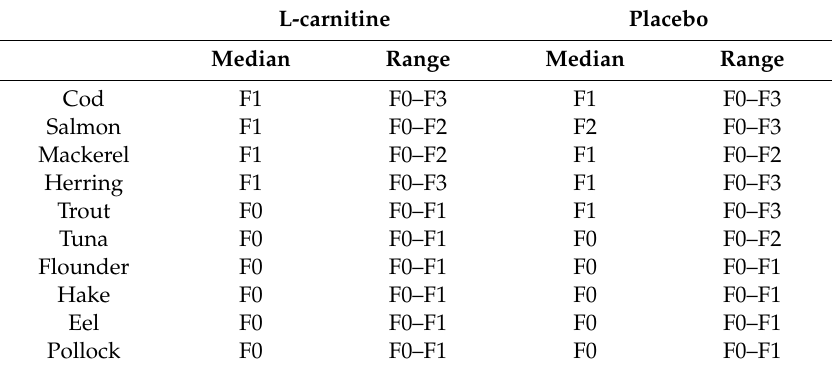
Table 3. The frequency of fish